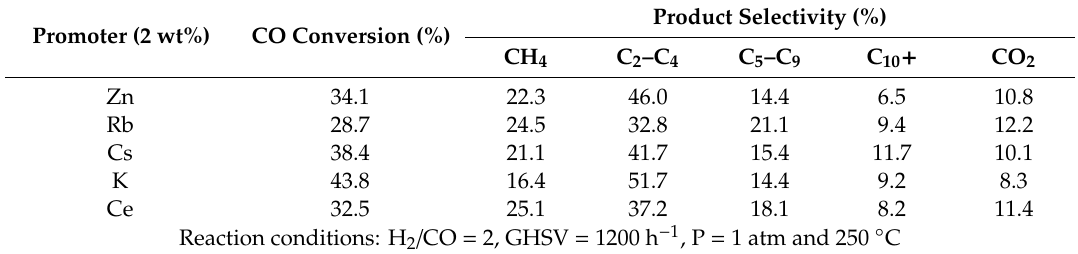
Product Selectivity (%) CH 4 C 2 –C 4 C 5 –C 9